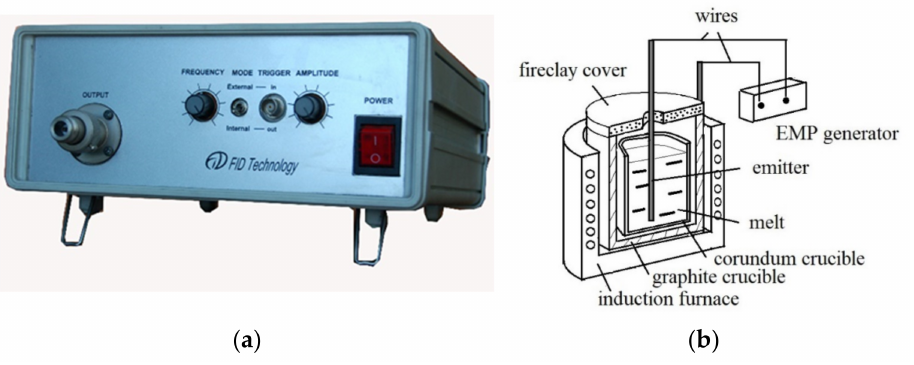
Figure 1. ( a ) EMP generator; ( b ) a schematic of the nanosecond EMP treatment